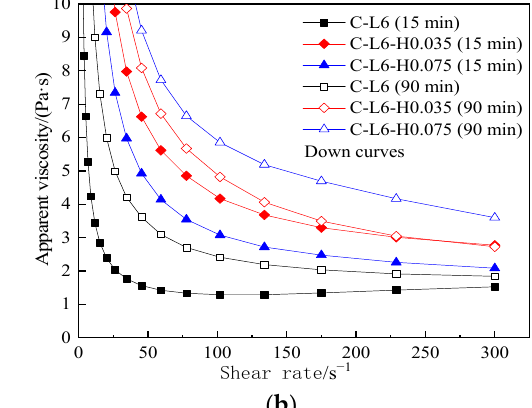
Table 10. Rheological parameters of C-L6-HPMC pastes.